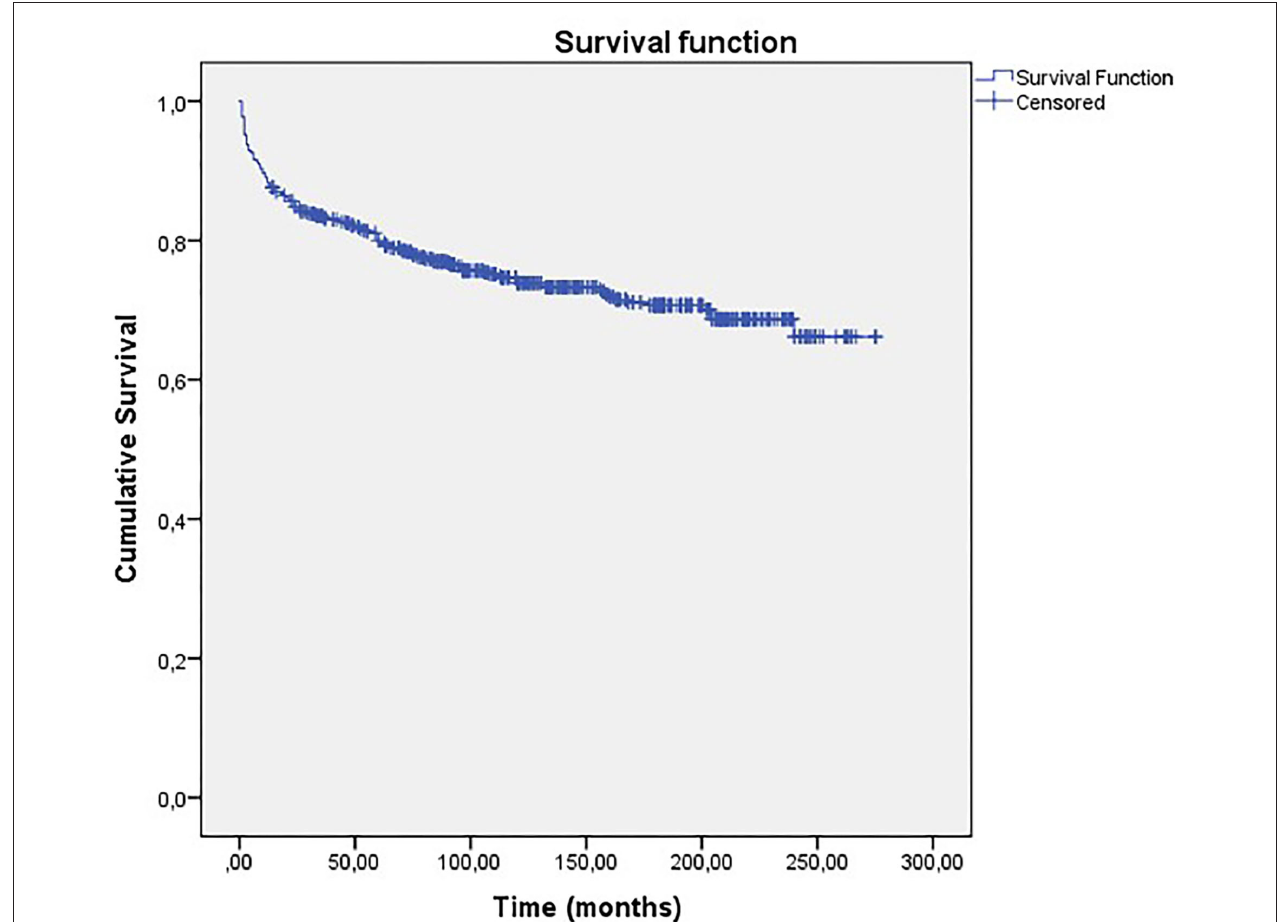
FIGURE 3 | Kaplan-Meier curve of long-term seizure outcomes for all